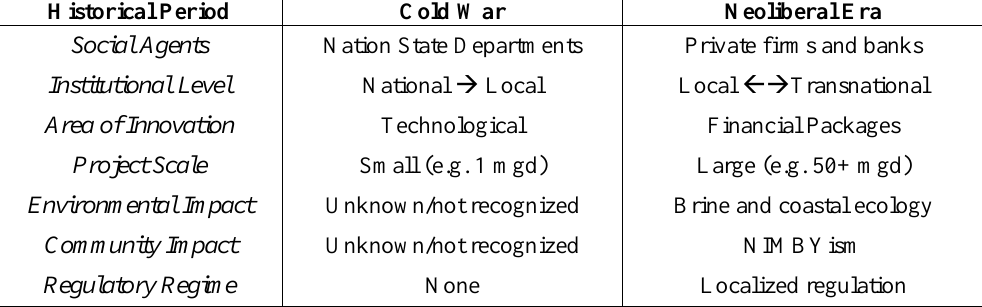
Table 1: Periodization of the World Ecology of